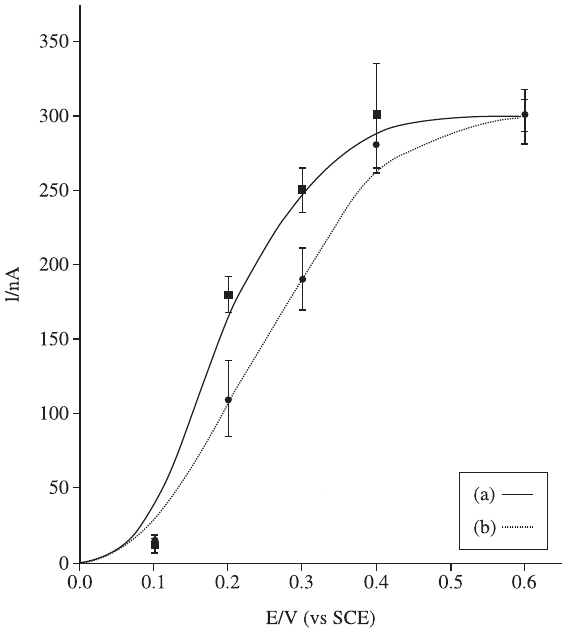
Figure 3. The relationship between the response current and the potential of the PGLD/GOx (a) and CHD/GOx (b) biosensors in NaPBS pH 7.4 at 37 °C. Glucose concentration: 20 mM. The error bars represent standard deviations between five electrodes.